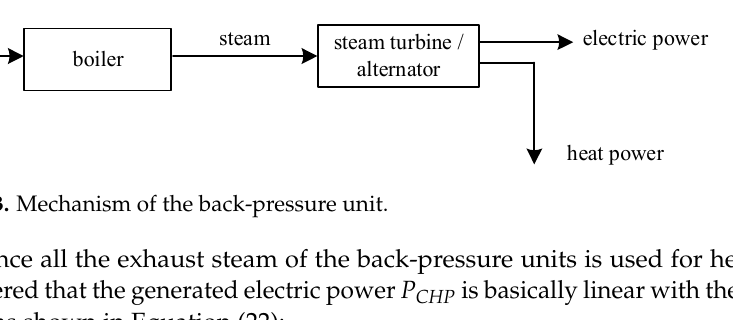
The electrothermal characteristic diagram of the back-pressure unit is depicted in Figure